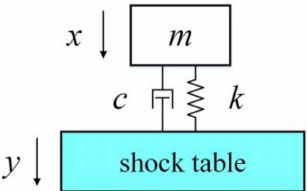
Figure 5. Single degree of freedom shock